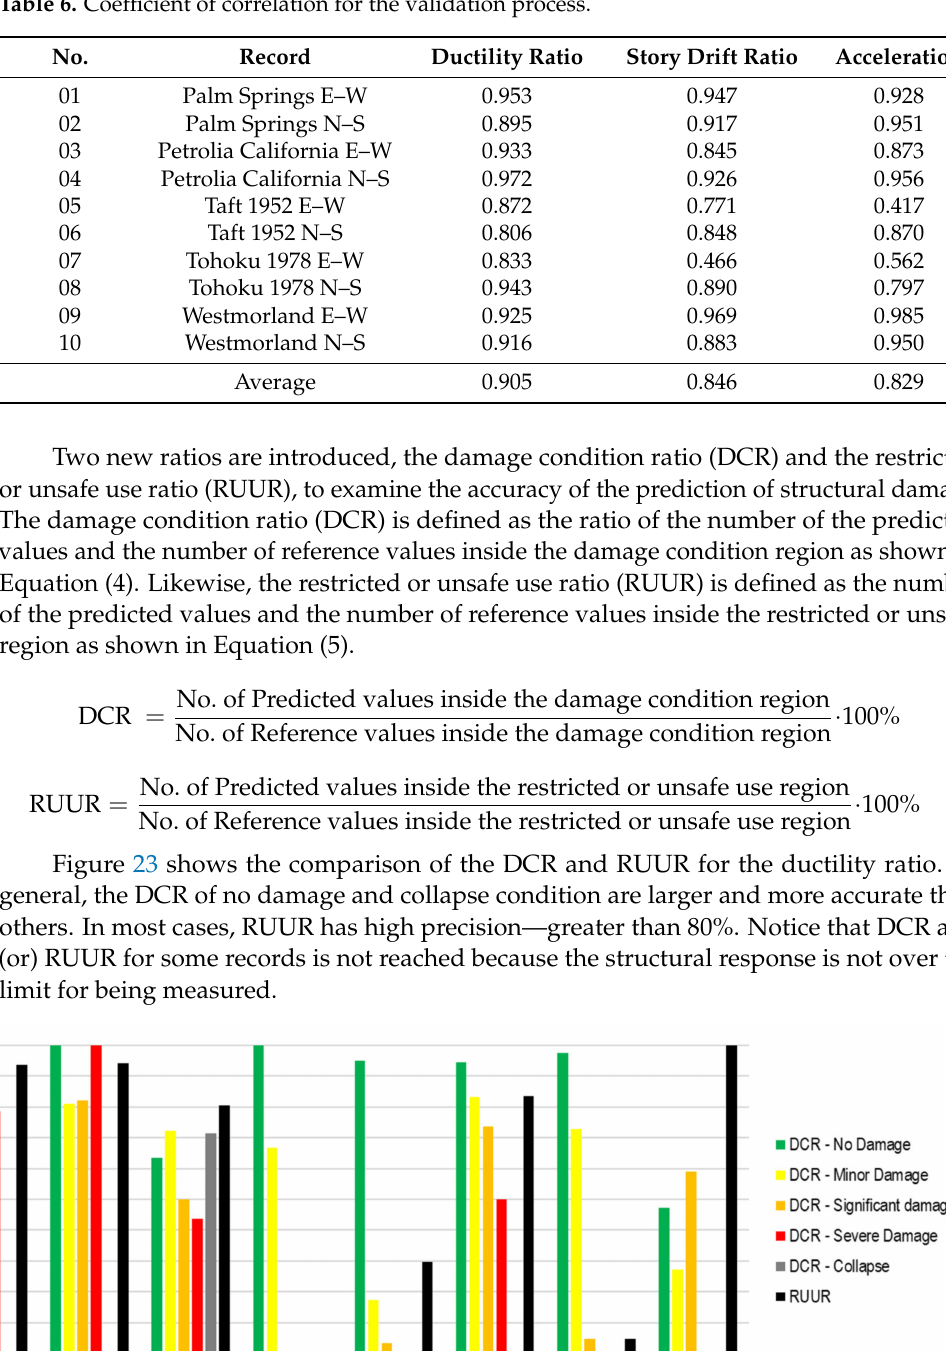
Table 6. Coefficient of correlation for the validation process.